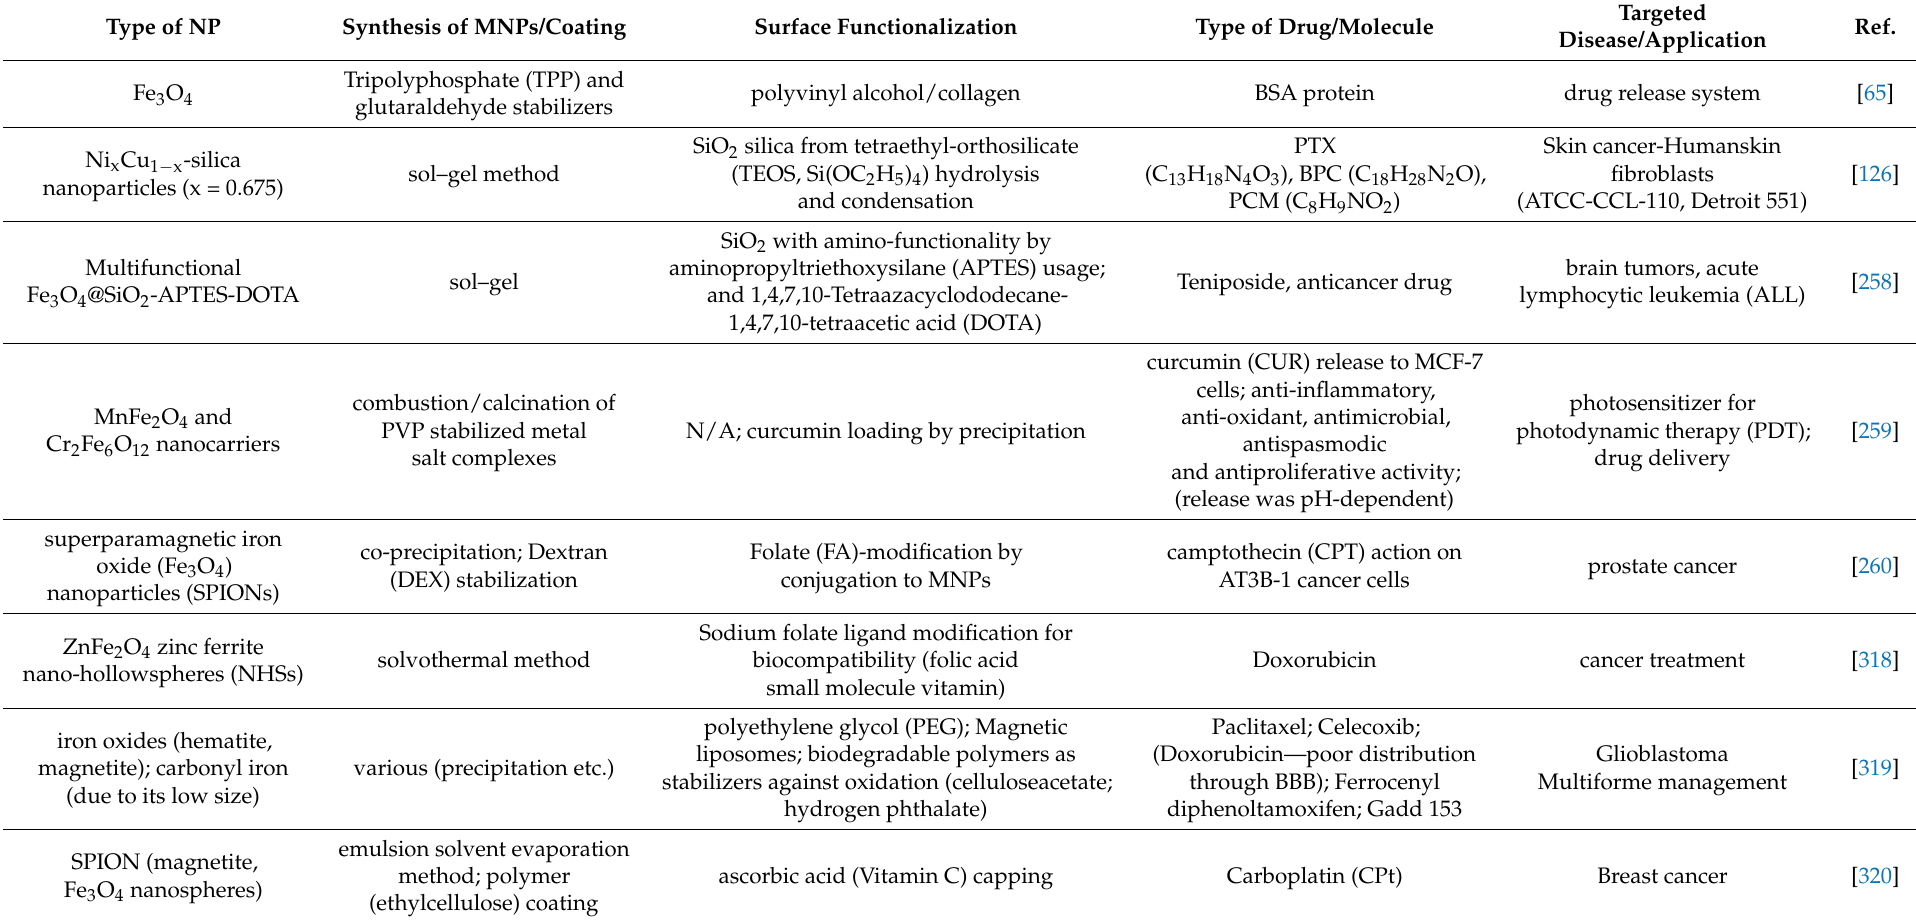
Table 1. An overview of recent drug-delivery parameters for drug-delivery